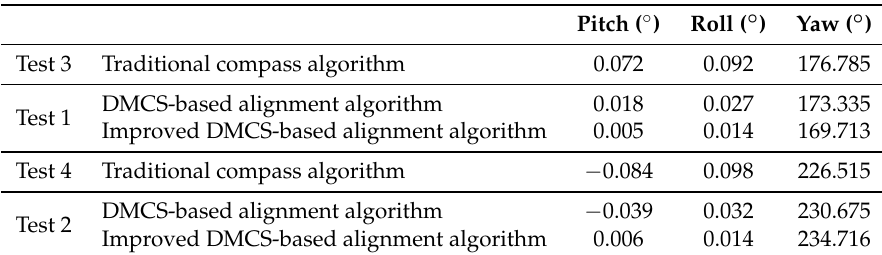
Table 2. Initial alignment results after 15 min.